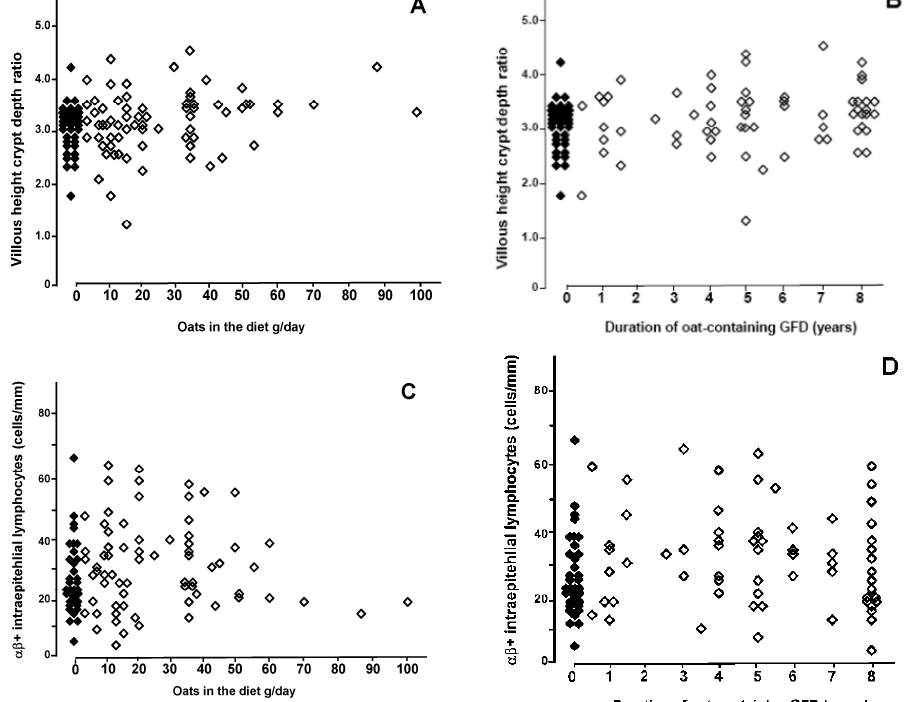
Figure 1. Small-bowel mucosal villous height crypt depth ratios in 106 treated celiac disease patients correlated with the daily oat intake ( A ) r = 0.251, p = 0.009 and the duration of oat consumption ( B ) r = 0.252, p = 0.012. Correlations between densities of αβ + intraepithelial lymphocytes and daily oat intake ( C ), and between the cells and the duration of oat consumption ( D ) were not statistically significant ( r = 0.152, p = 0.119 and r = 0.132, p = 0.190, respectively). GFD = gluten-free diet. Black diamond = no oats. Open diamond = oat